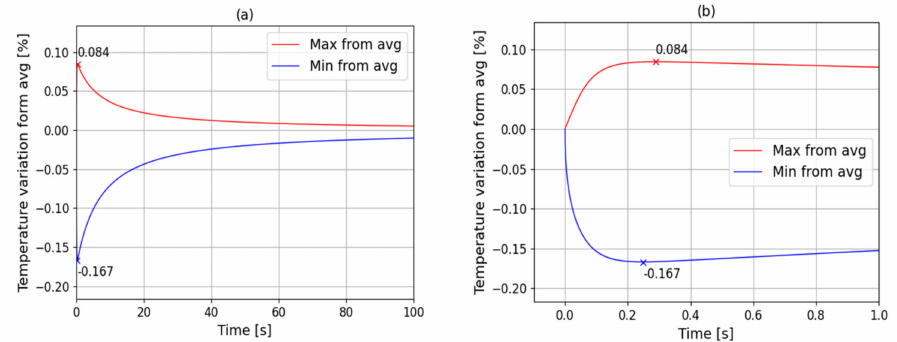
Figure 12. Percent deviation of maximum and minimum temperatures from average for the simplified model of the emitter. ( a ) Simulation for 100 s with 0.01 s timestep. ( b ) Simulation for 1 s with 0.0001 s